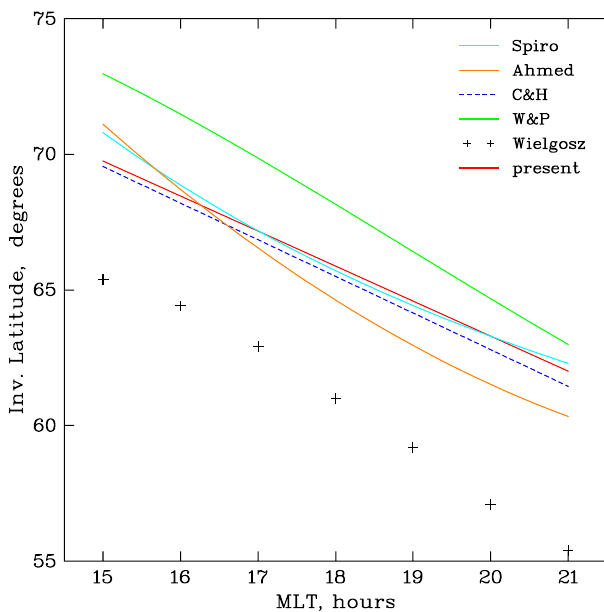
Fig. 14. Magnetic local time variation of the trough position. Re- sults obtained by Spiro (1978; blue curve), Ahmed et al. (1979; or- ange curve), Collis and H¨aggstr¨om (C&H, 1988; dashed cyan line), Werner and Pr¨olss (W&P, 1997; green curve), Wielgosz et al. (2004; crosses), and the present author ( latm , red line) are compared. The format of data presentation corresponds to that of Fig.